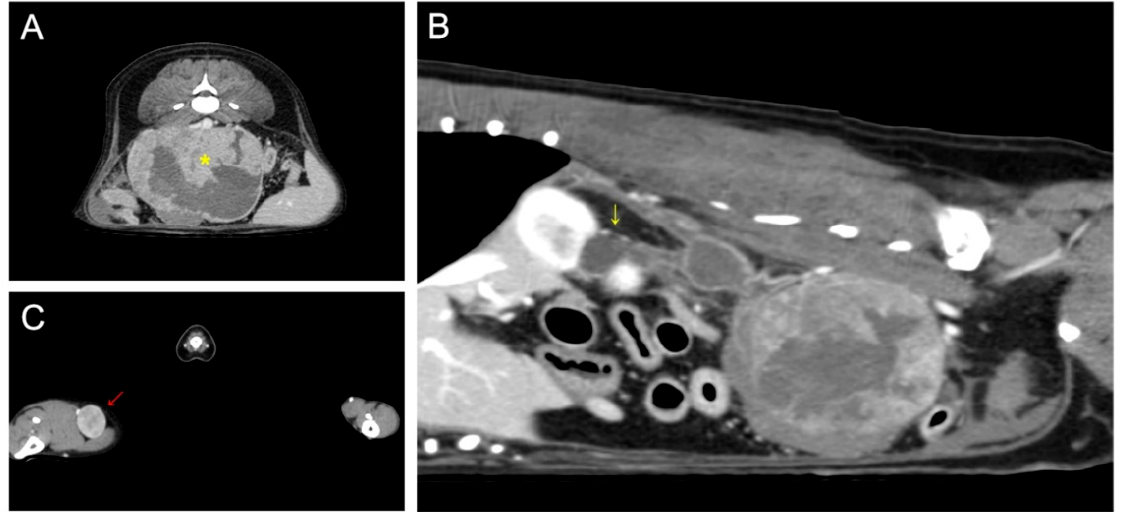
Figure 1. Preoperative computed tomography: ( A ) retroperitoneal mass (yellow asterisk) suspected of being metastasis from the right metatarsal skin mass; ( B ) proximal hydroureteronephrosis (yellow arrow) caused by compression of the distal ureter by the retroperitoneal tumor; ( C ) enlarged right popliteal lymph node (red arrow).